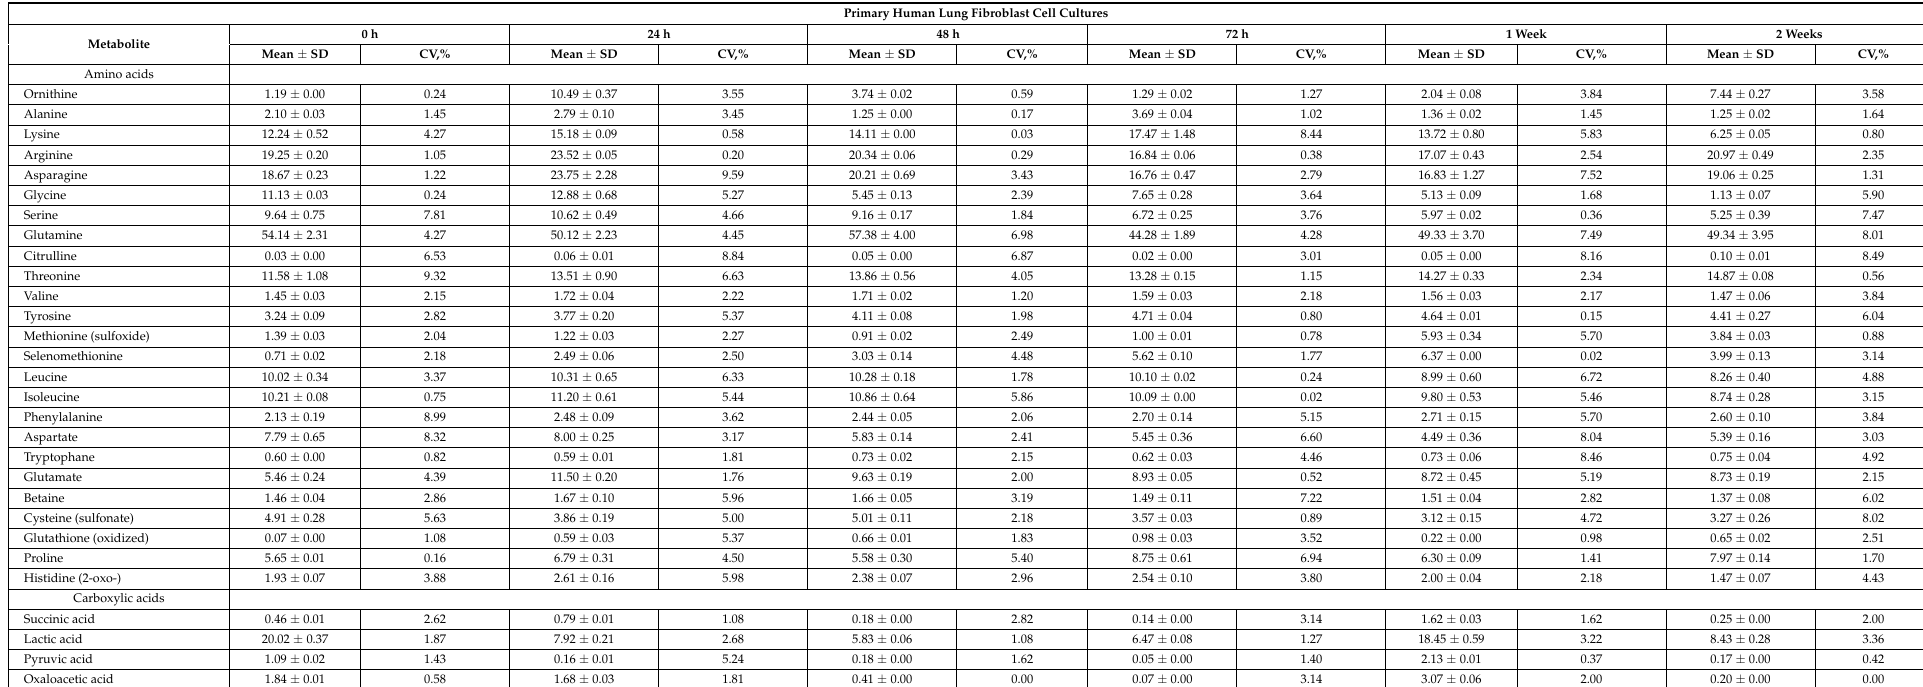
Table 10. Quantitative measurements of amino- and carboxylic acids obtained using time-of-flight quadrupole MS from samples of primary human lung fibroblast cell cultures in two technical replications. Unit of measurement, µ M, or 10 –6 M, N/D—non-detectable. Amino acids and carboxylic acids are presented in ascending order of retention time. (For complete data, see Supplementary Materials, Table